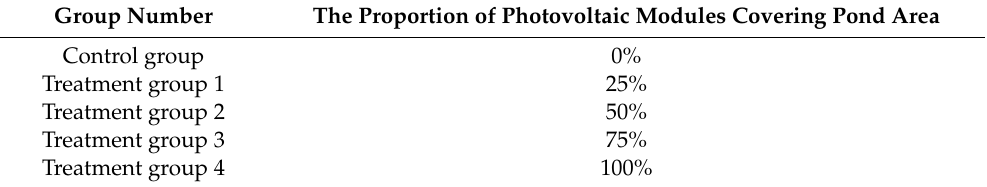
Table 1. The layout ratio table of photovoltaic stimulation panel. Group